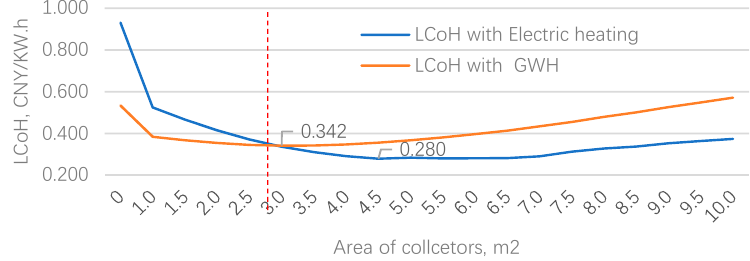
Figure 16. The LCoH curves with the area (m 2 ) of collectors with di ff erent auxiliary heat sources.